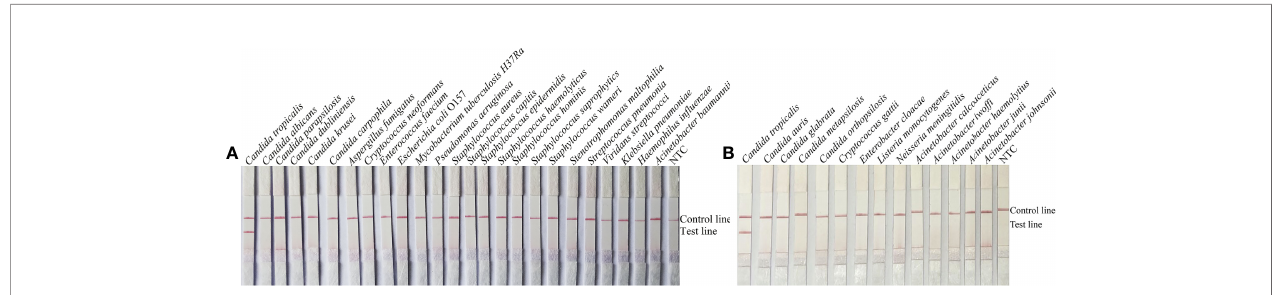
FIGURE 5 | Speci fi city of F5/P/R1B. (A, B) C . tropicalis ATCC 20962 was used as a positive control against other pathogenic bacteria tested, and species names are indicated at the top of each strip. NTC indicates no template control. The positions of the test and control lines are marked on the right side of the bars. Reactions were performed at 39°C for 20 min. Images are representative of three independent experiments.